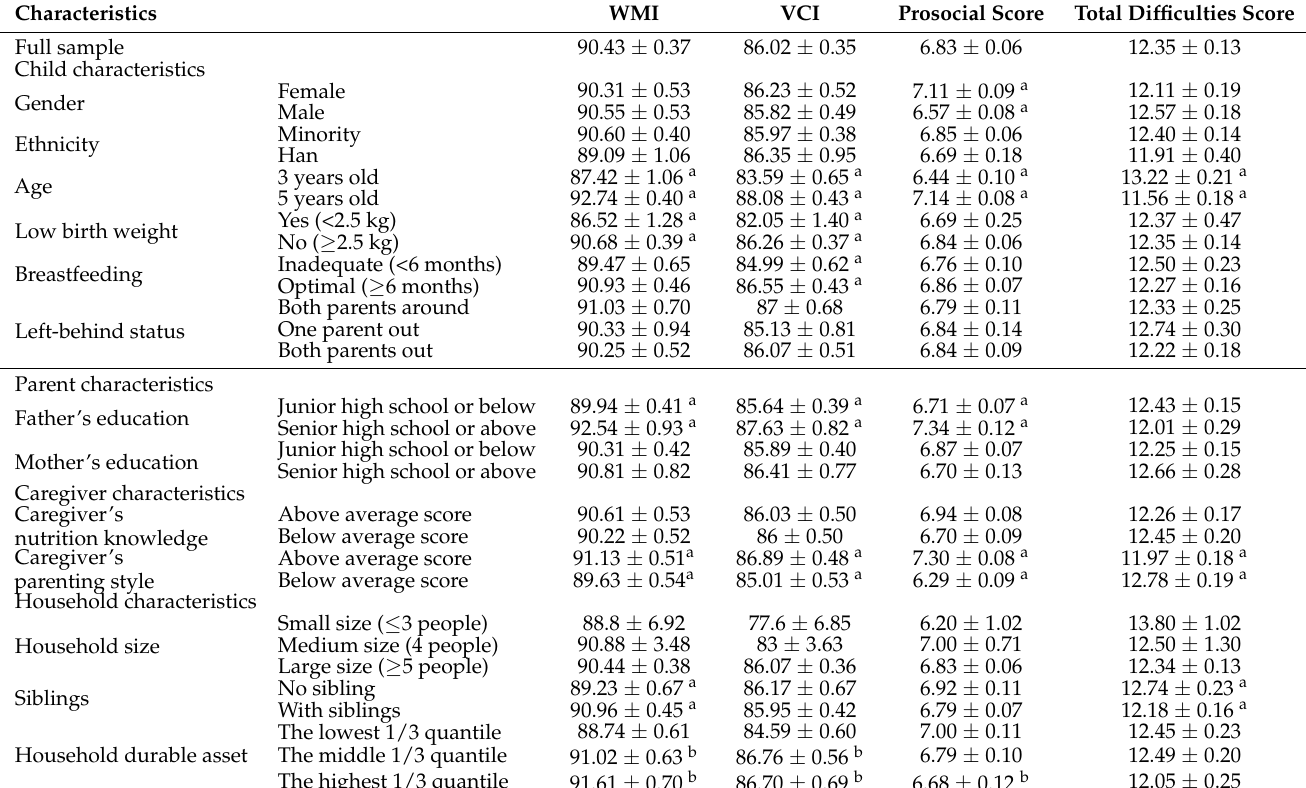
Table 2. Characteristics and distribution of sample children by development indicators, Values are mean ±